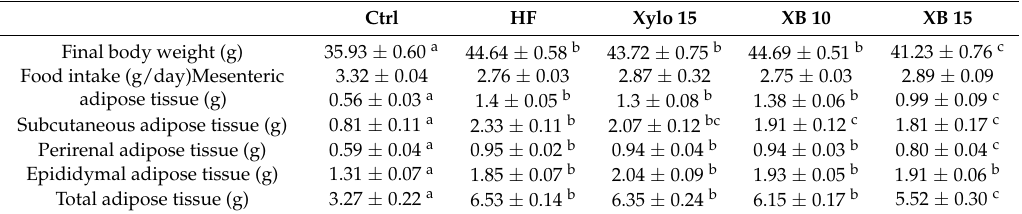
Table 1. Body weight, food intake, and adipose tissue weights of mice fed with different diets for 10 weeks 1 .